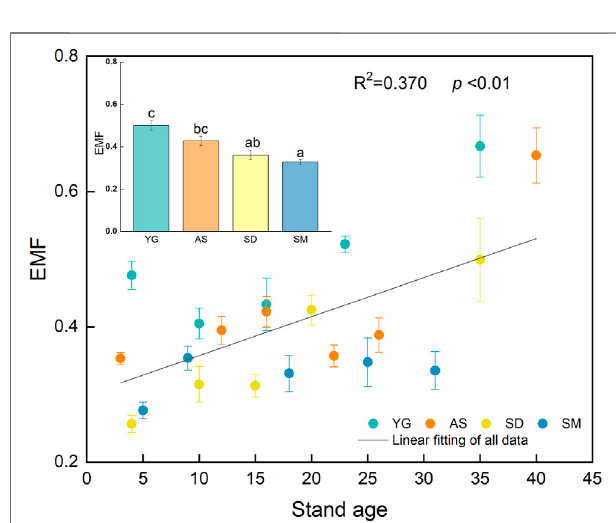
FIGURE 4 | The temporal variations and means of EMF at the four sites. R 2 and p values are for the linear fi ts of the overall data. The bar charts showed the differences in the EMF among sites. Different letters indicate signi fi cant differences at p < 0.05. Error bars are standard error